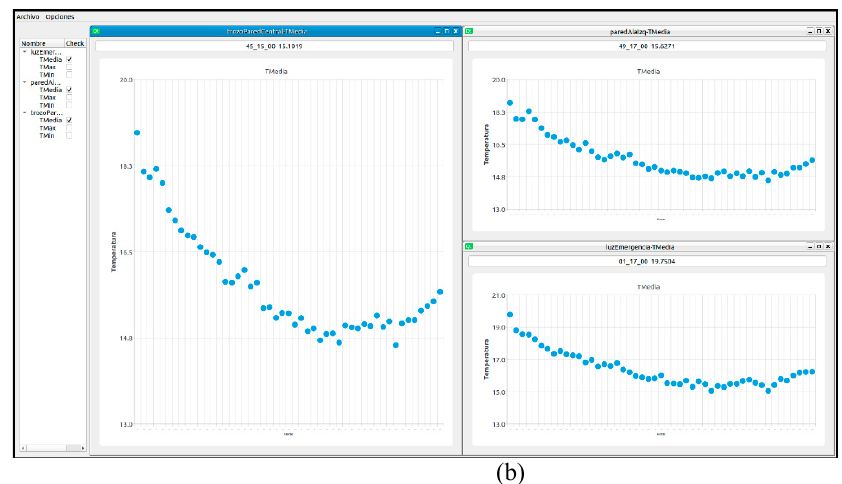
Figure 14. 3D-TTA Module 2: ( a ) Example of the selection and labeling of three regions. ( b ) Graphics of the temperature evolution over time and basic statistical indicators for each region.